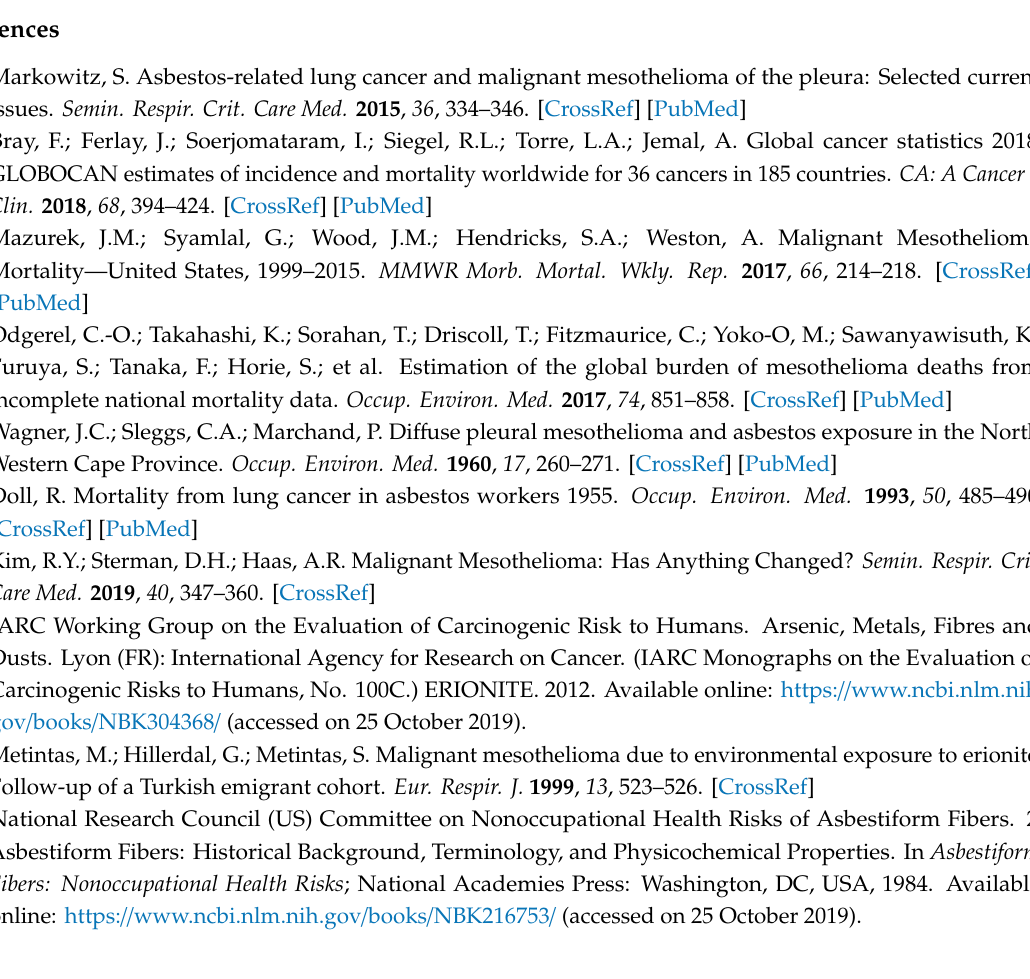
Table S1: Search terms, Table S2: Quality assessment of selected